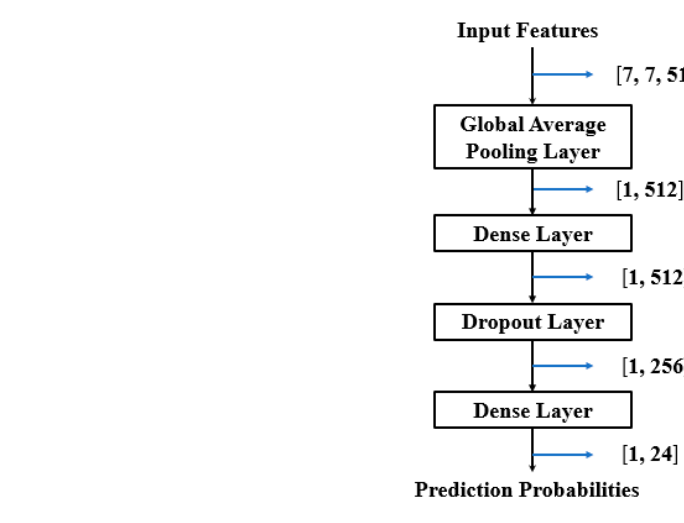
Figure 10. Classification block for each